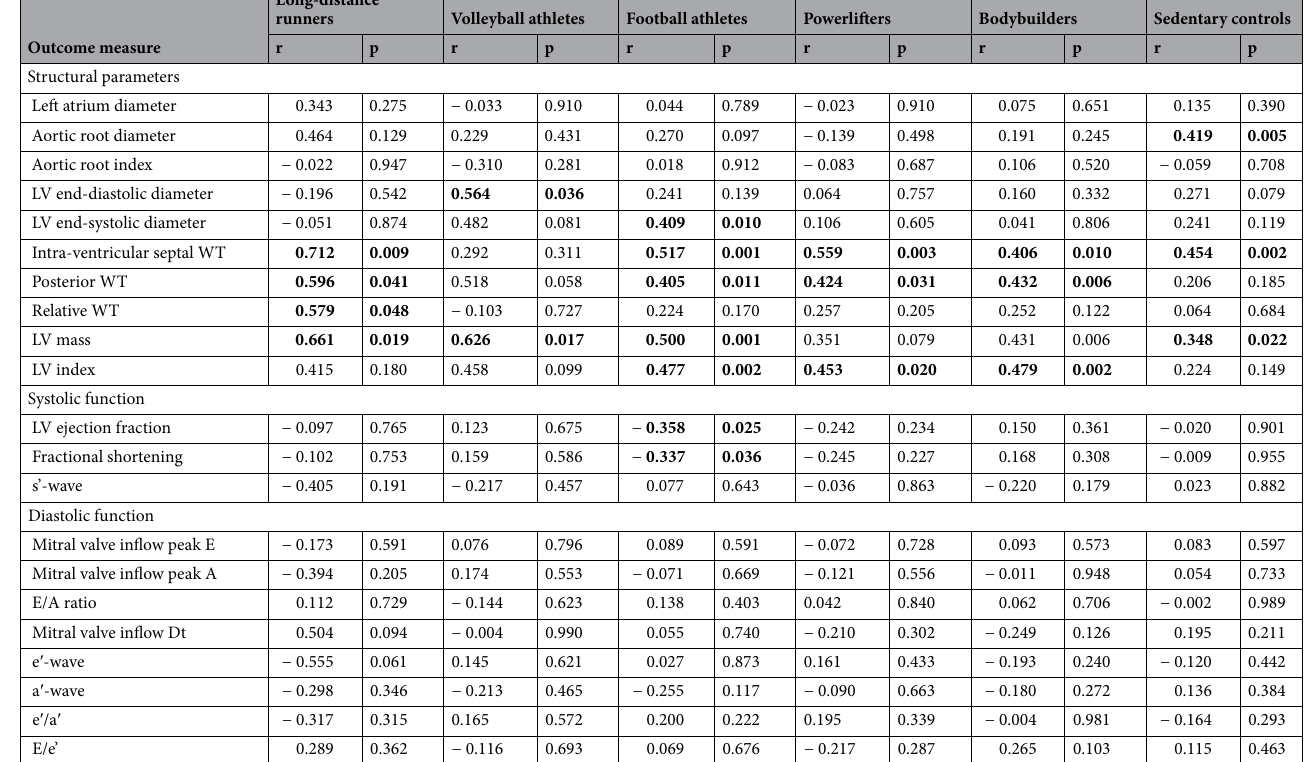
Table 4. Pearson product-moment correlations between corrected QT dispersion and echocardiographic parameters in long-distance runners (n = 12), volleyball athletes (n = 14), football athletes (n = 39), powerlifters (n = 26), bodybuilders (n = 39), and sedentary controls (n = 43). Relative wall thickness = (2 × posterior wall thickness)/LV end-diastolic diameter; bolded values indicate significant (p ≤ 0.05), moderate-very large correlation. LV left ventricular, WT wall thickness, Dt deceleration time, s’-wave systolic mitral annulus velocity (average of septal and lateral measurements), e’-wave early diastolic myocardial relaxation (average of septal and lateral measurements), a’-wave active atrial contraction in late diastole (average of septal and lateral